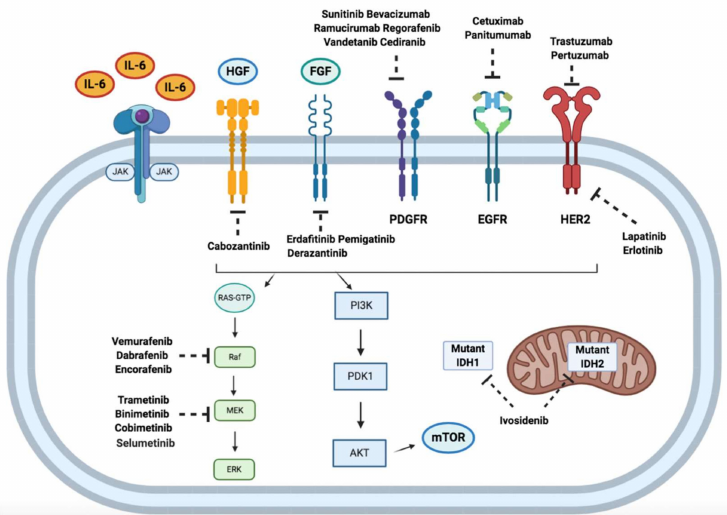
Figure 2. Schematic figure reporting therapeutically relevant signaling pathways and selected targeted therapies currently under evaluation for biliary tract cancer. AKT: protein kinase B; EGFR: epidermal growth factor receptor; FGF: fibroblast growth factor; HER2: epidermal growth factor receptor 2; HGF: hepatocyte growth factor; IL-6: interleukin 6; IDH: isocitrate dehydrogenase; JAK: Janus kinase; mTOR: mammalian target of rapamycin; PDGFR: platelet derived growth factor receptor; PDK1: phosphoinositide-dependent kinase-1; PI3K: phosphoinositide